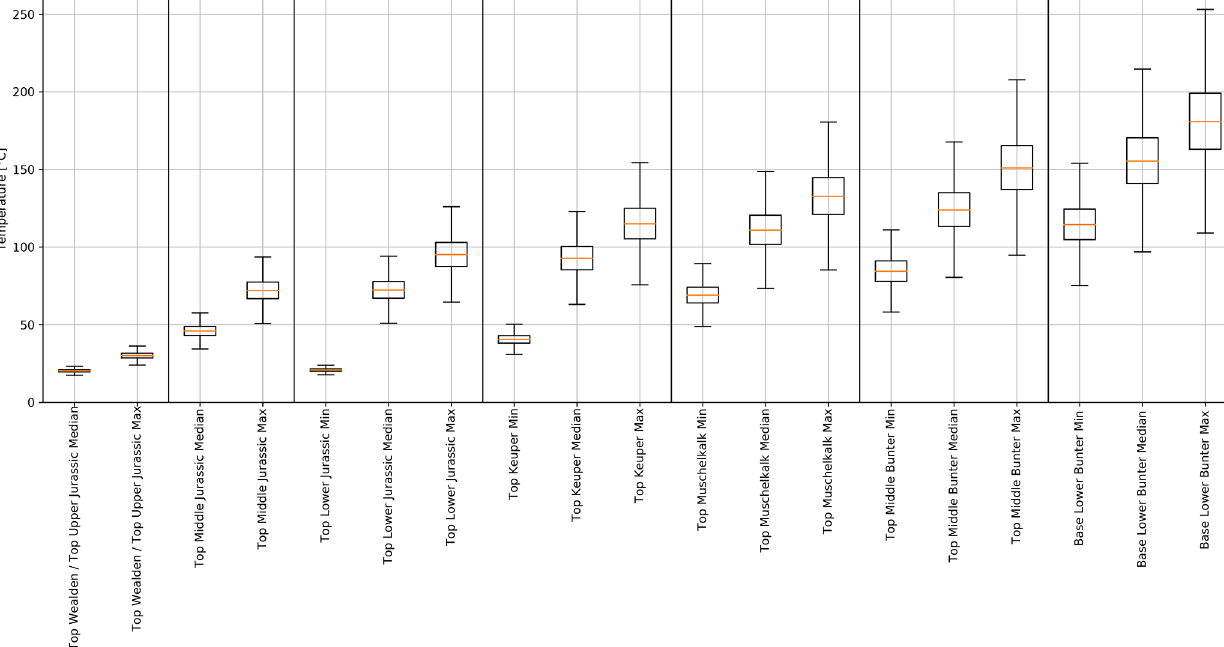
Figure 5. Boxplots showing the temperature distributions for the different tops and base (Lower Bunter) of the different stratigraphic units. Minimum, where available, median and maximum temperature scenarios are given for each stratigraphic unit. The temperature ranges are a function of the depth uncertainty of each